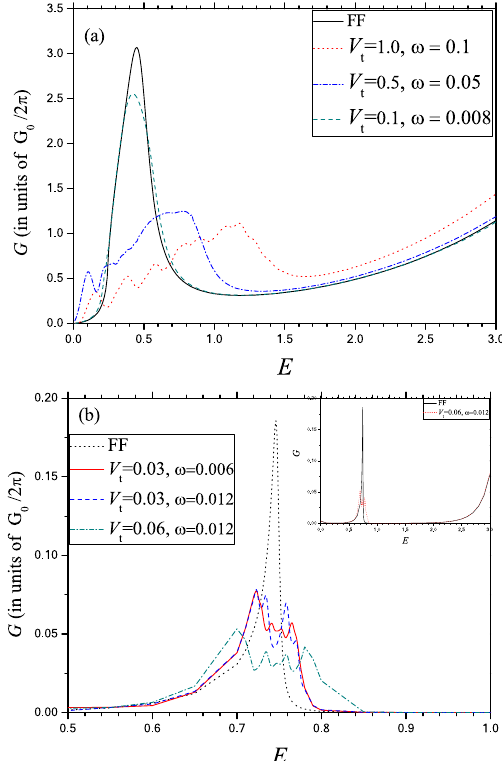
G 0 Figure 7. Zero temperature conductance G (in units of 2 π ) v.s. E through an oscillating electrostatic in phosphorene. ( a ) Barrier along the Г–X direction for D = 1 and V 0 = 4. Solid (black) for FF; Dot (green) for V t = 0.1 and ω = 0.008; Dash dot (blue) for V t = 0.5 and ω = 0.05; Dash (red) for ω = 0.1 and V t = 0.1 ( b ) Barrier along the Г–Y direction for D = 1 and V 0 = 3. Dot (black) for FF; Solid (red) for V t = 0.03 and ω = 0.006; Dash (blue) for V t = 0.03 and ω = 0.012; Dash dot (green) for V t = 0.06 and ω = 0.012. INSET: For entire energy range under below barrier condition. Solid (black) for FF and dot (red) for V t = 0.06 and ω = 0.012.